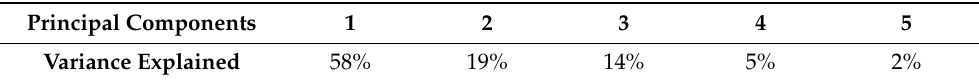
Table 3. Pareto analysis of principle components.